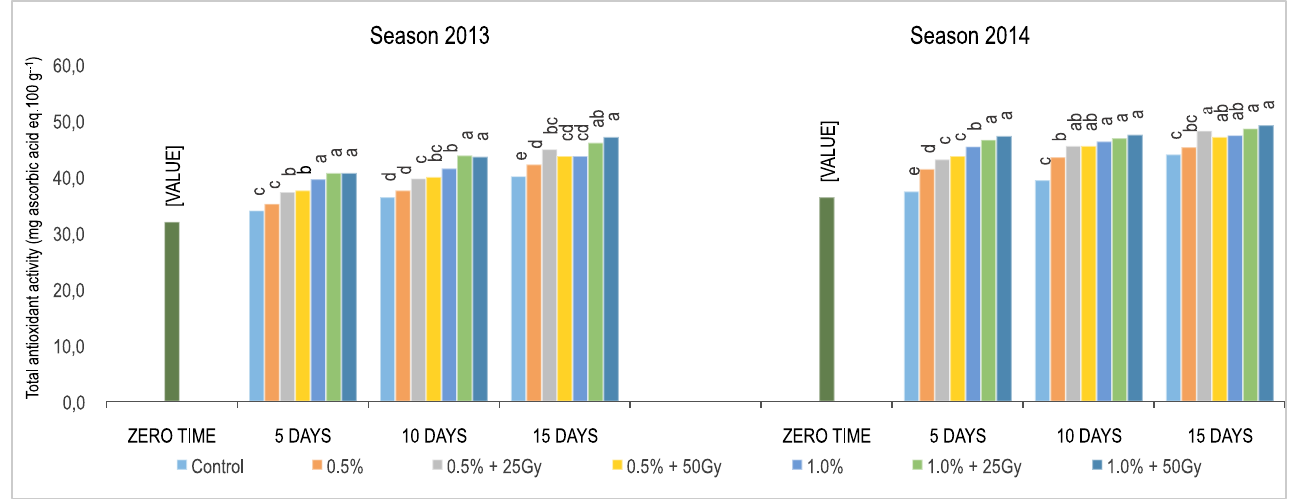
Fig. 3: Effect of irradiated and unirradiated chitosan on arils juice total antioxidant activity (mg ascorbic acid eq. 100 g -1 ) during cold storage. Columns in the same group bearing a common letter are insignificantly different at